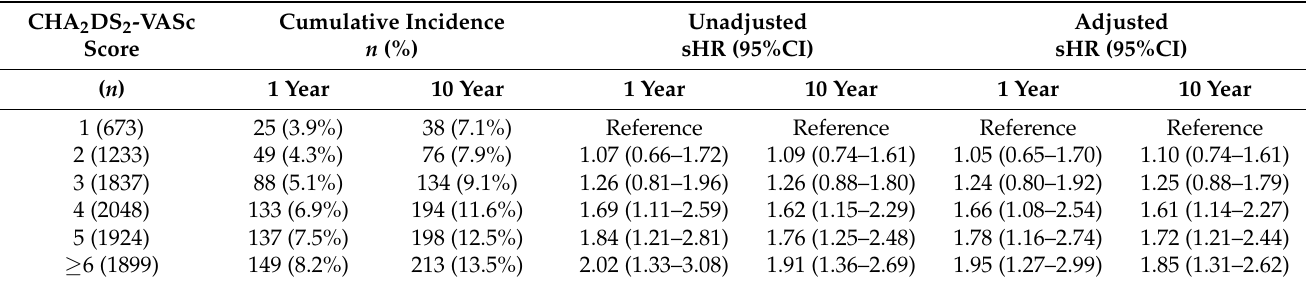
Table 4. Cumulative incidence of ischemic stroke in patients with new-onset atrial fibrillation